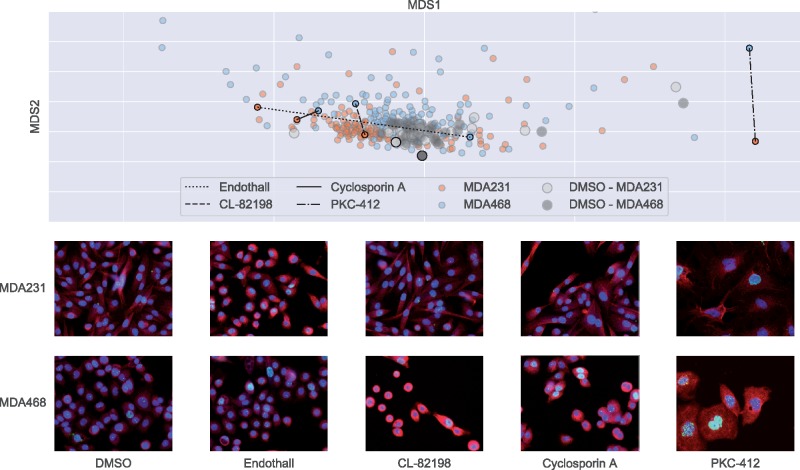
MDS embedding of drug effect profiles for MDA231 and MDA468 cell lines with DMSO centroid centered on origin. Detection of differential drug effects between cell lines with examples for each category below (MDA231 top and MDA468 bottom). From left to right: no drug effect in either cell line (negative control); drug effect in MDA231 cell line only; drug effect in MDA468 cell line only; similar drug effects in both cell lines; differentiated drug effects in both cell lines. Shown are example images, blue, DAPI; red, microtubules; green, DSB